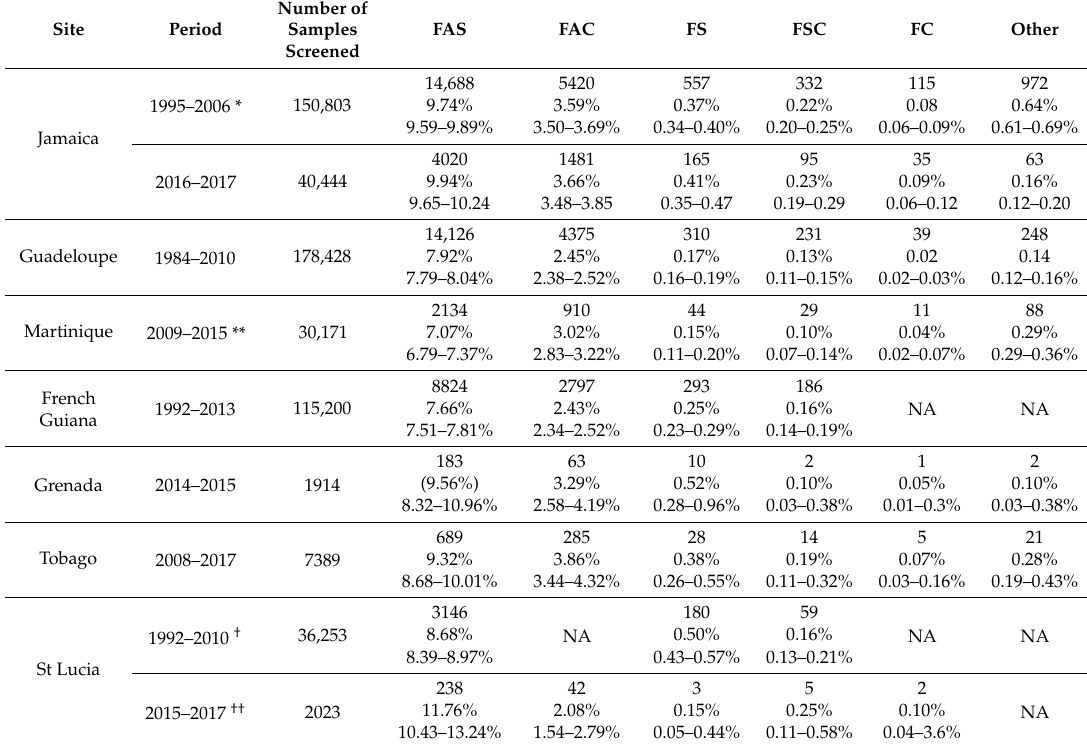
Table 2. Results from the newborn screening programs in the